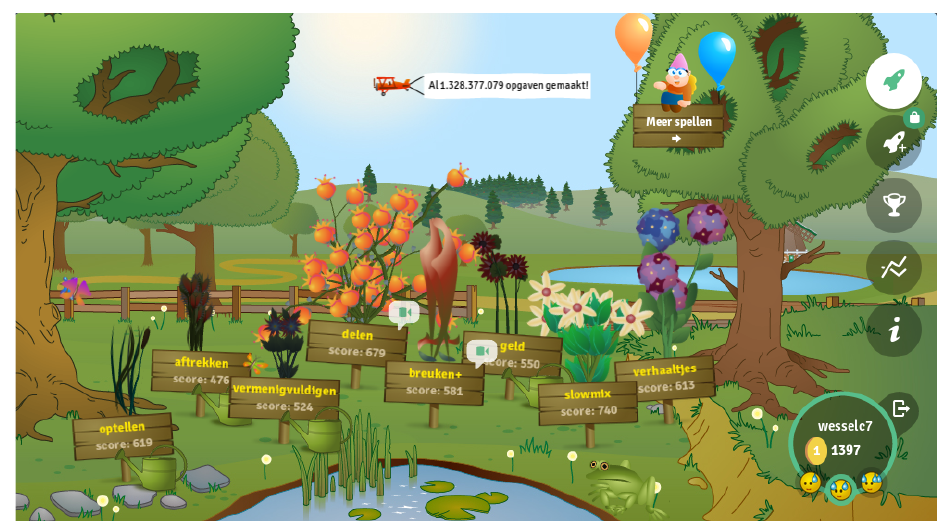
Figure 1. A screenshot of the landing page of the Math Garden, showing a selection of 8 games, representing 8 practice domains. Note that 4 plants appear withered and have watering cans in place, representing a naive governing